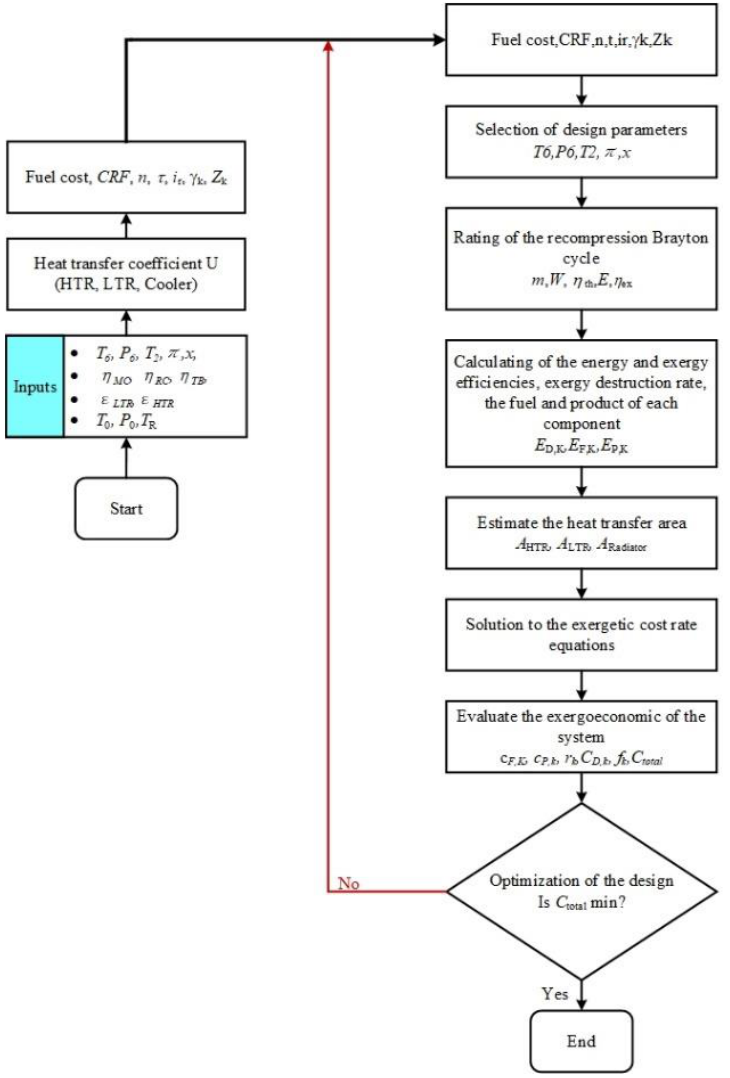
Figure 5. Optimization flowchart of the proposed S-(N 2 O-He) system.